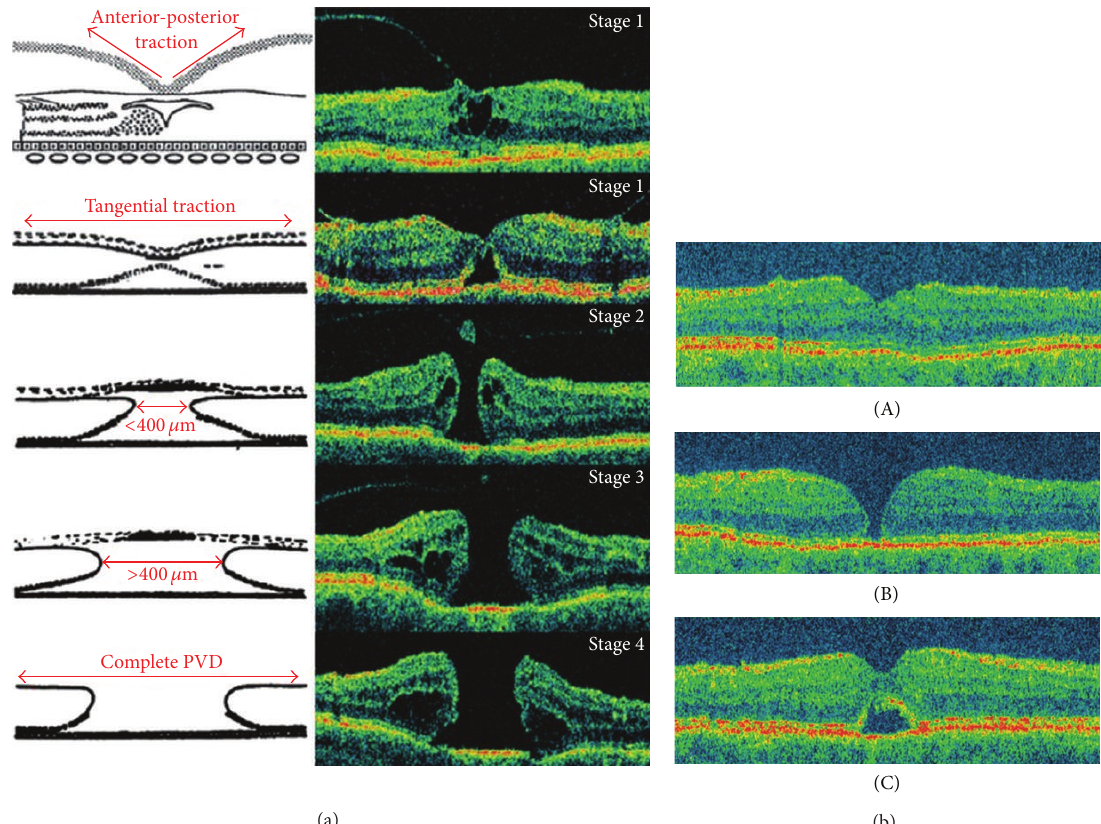
Figure 2: (a) Schematic and OCT representation of macular hole formation [1]. (b) Optical coherence tomography images 3 months after macular hole surgery. (A) Normal gross anatomic features with an attached fovea. (B) Flat edges with persistent neurosensory defect. (C) Contiguous foveal surface with persistent subfoveal fluid